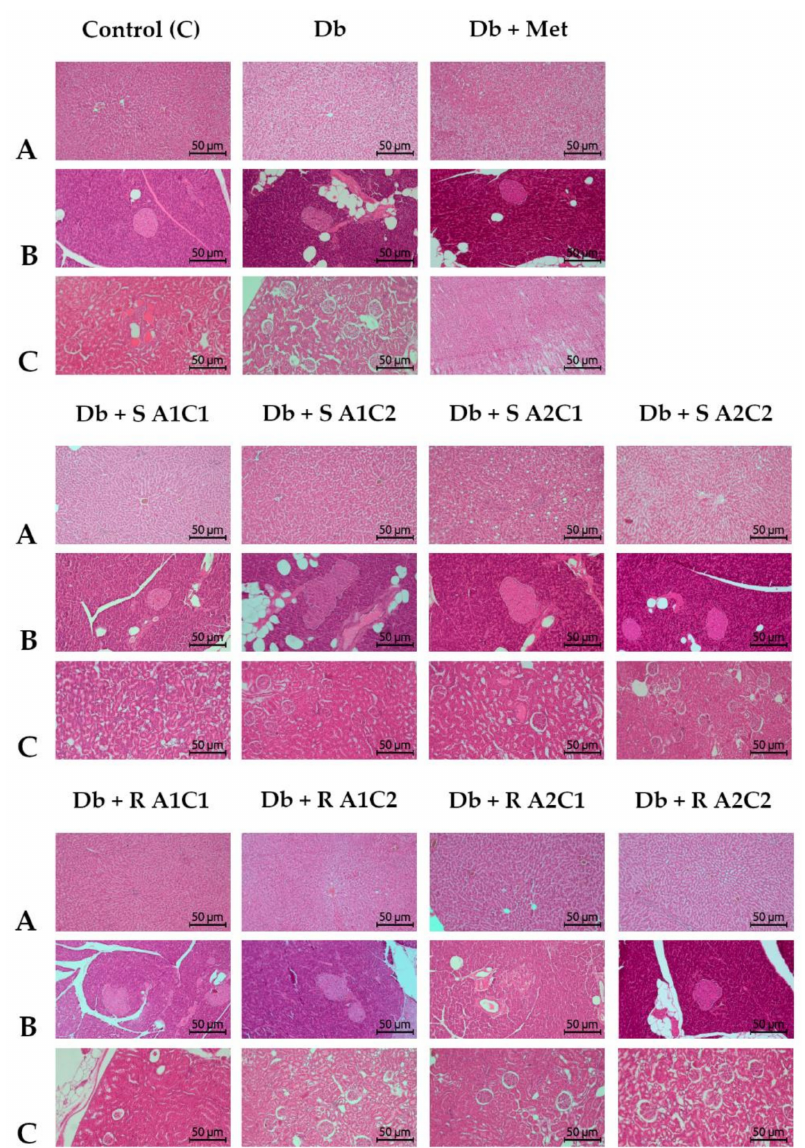
Figure 2. Effects of the diet and combined SG, L-arg, and Cr(III) supplementation on the liver, pancreas, and kidney histological alterations. Internal cross-sections of the ( A ) liver, ( B ) pancreas, and ( C ) kidneys (magnification 10 × ). Control group (C): healthy rats receiving AIN-93M diet; Db group: diabetic rats receiving HFD; Db + Met group: diabetic rats receiving HFD with 0.3% metformin; Db + S A1C1 group: diabetic rats receiving HFD with 2.5% ST, 2% L-arg and 0.001% Cr; Db + S A1C2 group: diabetic rats receiving HFD with 2.5% ST, 2% L-arg and 0.005% Cr; Db + S A2C1 group: diabetic rats receiving HFD with 2.5% ST, 4% L-arg and 0.001% Cr; Db + S A2C2 group: diabetic rats receiving HFD with 2.5% ST, 4% L-arg and 0.005% Cr; Db + RA1C1 group: diabetic rats receiving HFD with 2.5% RA, 2% L-arg and 0.001% Cr; Db + RA1C2 group: diabetic rats receiving HFD with 2.5% RA, 2% L-arg and 0.005% Cr; Db + RA2C1 group: diabetic rats receiving HFD with 2.5% RA, 4% L-arg and 0.001% Cr; Db + RA2C2 group: diabetic rats receiving HFD with 2.5% RA, 4% L-arg and 0.005%